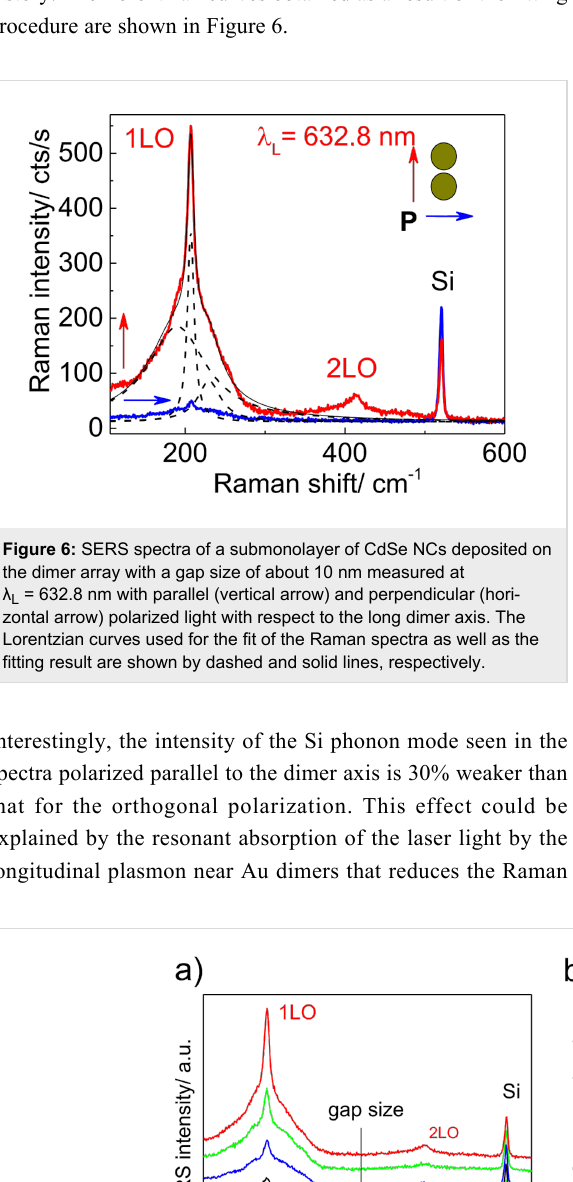
230 cm − 1 . The first can be attributed to scattering by surface optical modes, which was previously well-investigated in CdSe NCs [45,49,50]. The latter may originate from SERS by amor- phous selenium formed on the NC surface due to partial photodegradation of CdSe NCs under laser illumination [51,52]. This mode has somewhat different intensity and shape for different Au arrays and depends on the sample preparation history. The Lorentzian curves obtained as a result of the fitting procedure are shown in Figure 6.